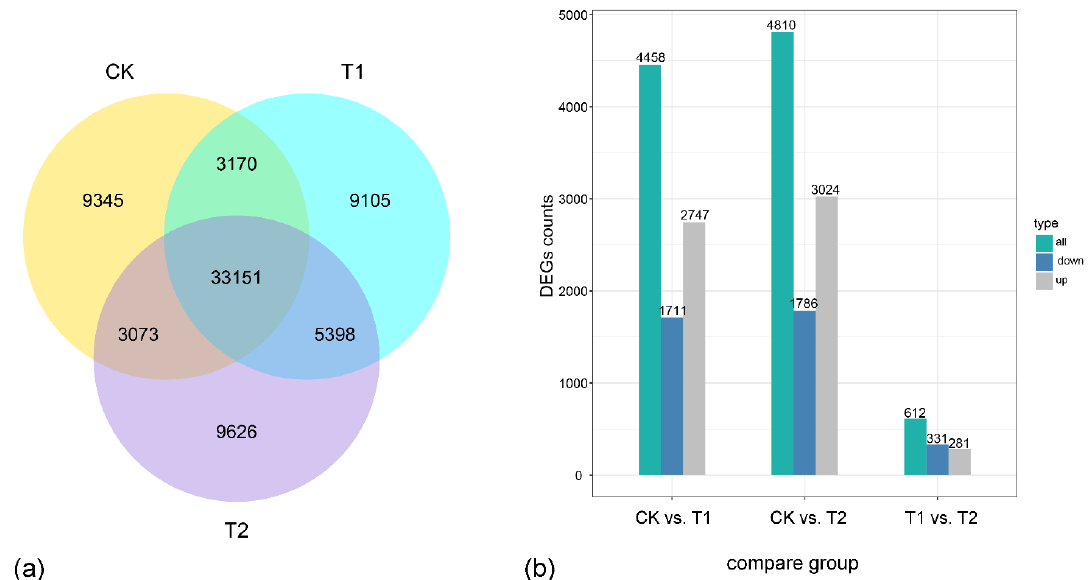
Figure 3. Number of DEGs under the heat stress conditions in Michelia macclurei . ( a ) Venn diagram analysis of DEGs of three samples. ( b ) The column diagram in three comparisons between two samples. The x-axis is each comparison, and the y-axis represents the up- and down-regulated gene numbers.